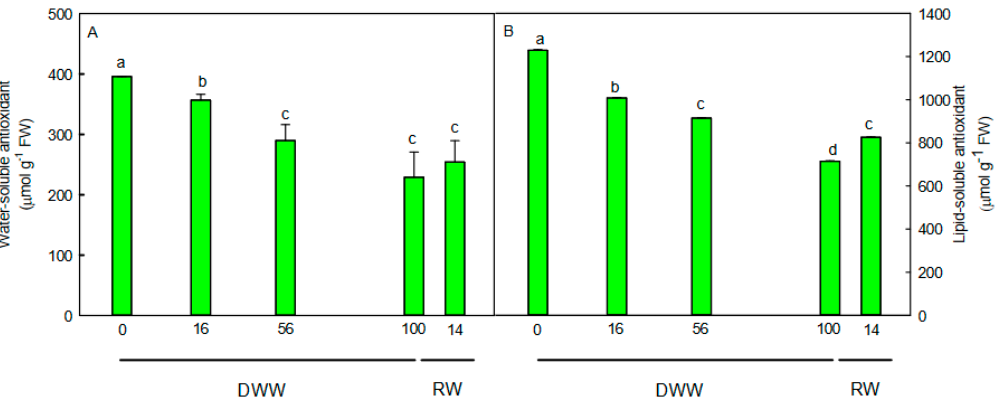
Figure 4. ( A ) water-soluble and ( B ) lipid-soluble antioxidants during days without water (DWW), and rewatering (RW). Di ff erent letters indicate statistically significant di ff erences ( p ≤ 0.05) among di ff erent days. Data were analyzed by one-way ANOVA repeated measurements followed by Tukey’s test. Data are means ( n = 10) ± SE.